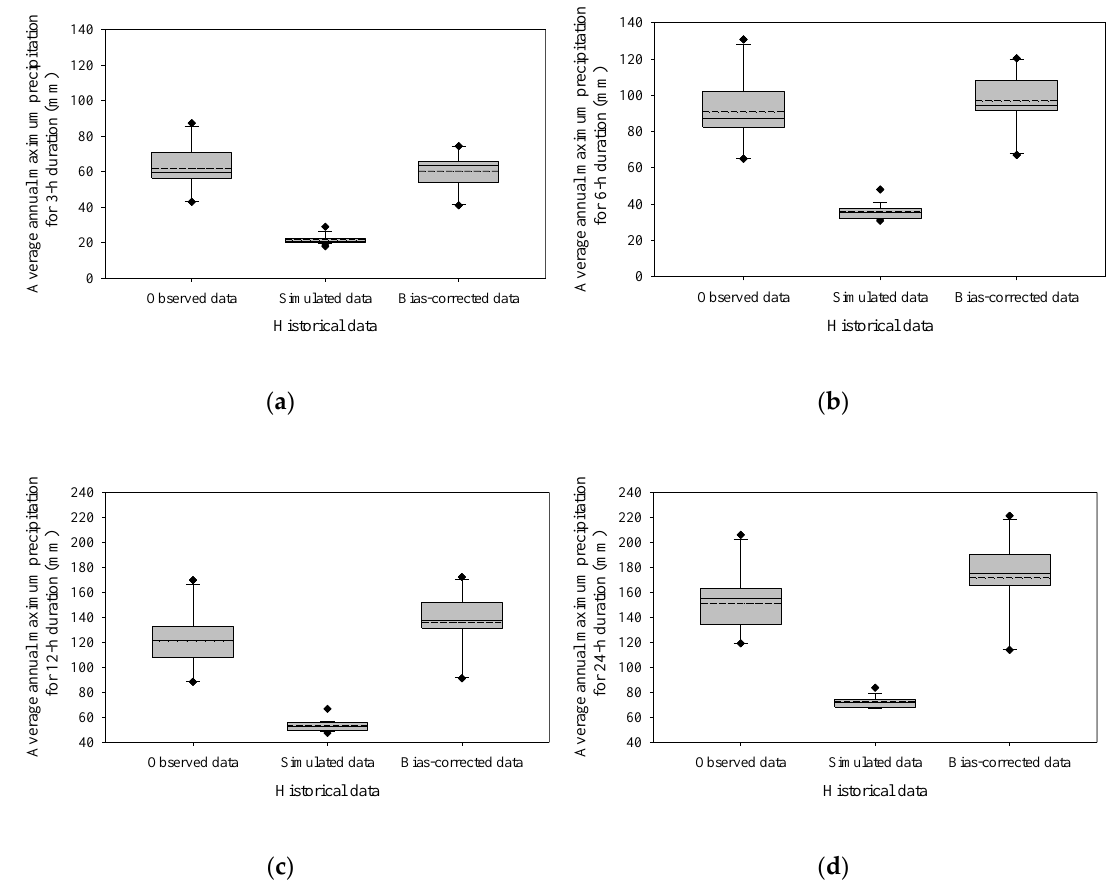
Figure 4. Bias-correction result of the past 30-year (1976–2005) average annual maximum precipitation for four durations (3, 6, 12, and 24-h) for 30 agricultural reservoir watersheds. The dotted line is the average, whereas the solid line is the median. The diamond symbol represents outliers. ( a ) 3-h duration; ( b ) 6-h duration; ( c ) 12-h duration; ( d ) 12-h duration.